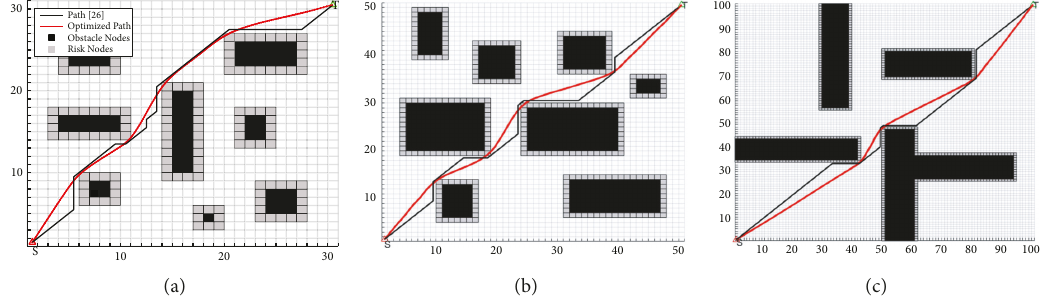
Figure 14: Improved A ∗ algorithm [25]. (a) 30 ∗ 30. (b) 50 ∗ 50. (c) 100 ∗ 100.